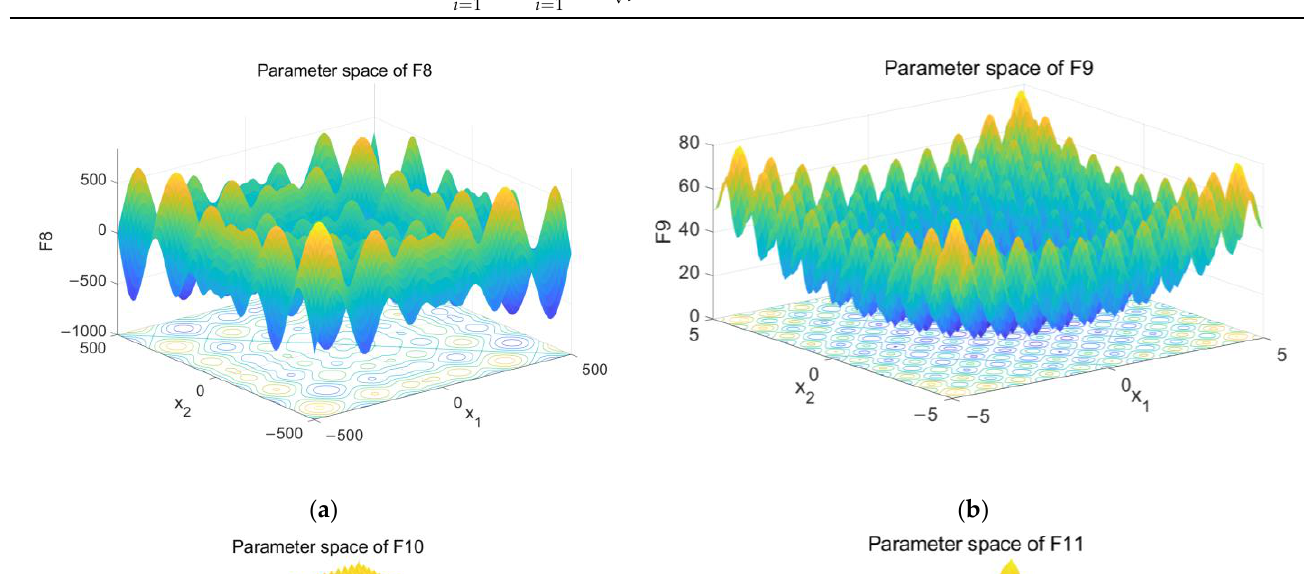
Table 4. Details of the multimodal test function.